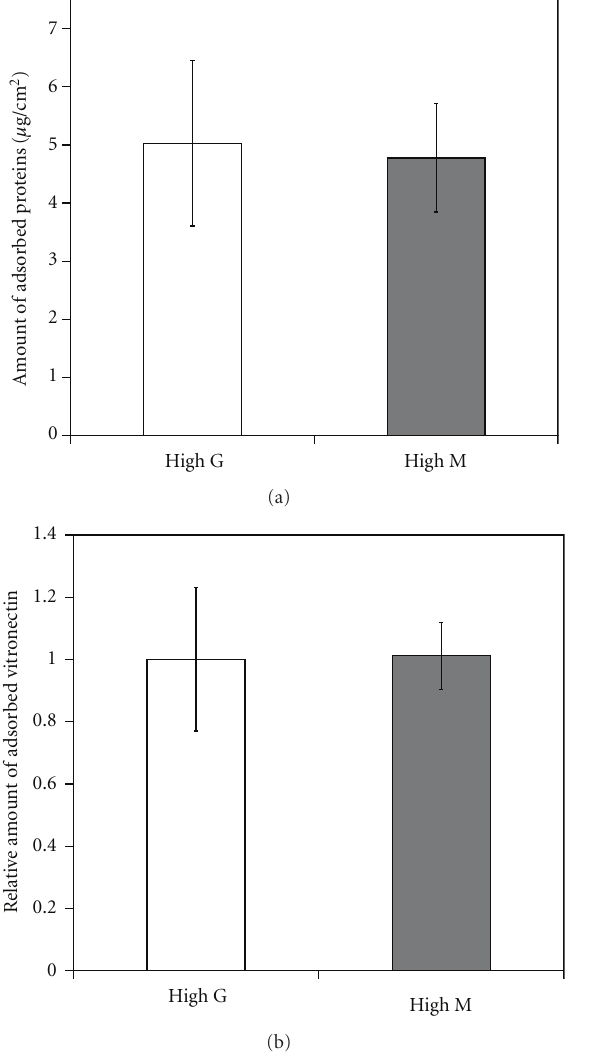
Figure 3: Protein adsorption on Fe-alginate films. The amount of total adsorbed serum proteins was quantified using a BCA protein assay kit (a). Adsorbed serum vitronectin was evaluated by immunoblotting (b). The relative amount of adsorbed vitronectin was normalized relative to that adsorbed on high-G Fe-alginate. Error bars indicate standard deviation for n = 3.